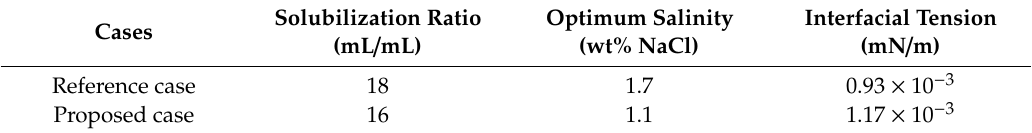
Table 4. Summary of the salinity scan test.